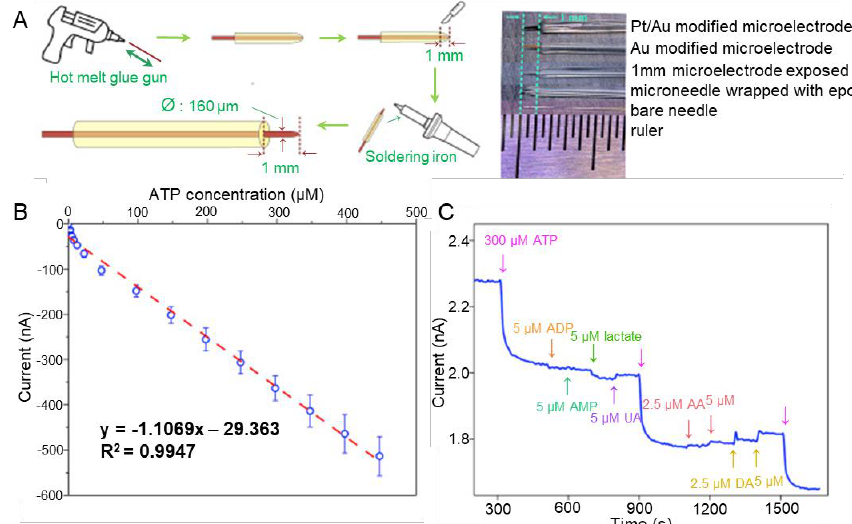
Figure 3. Au/Pt-hybrid-based needle-type aptamer sensors for detection of ATP as neurotransmitter. ( A ) Schematic illustration of the fabrication process of the metal-hybrid-based aptamer sensor. ( B ) Linear plot indicating the linear range and LOD of ATP. ( C ) Selectivity of the fabricated aptamer sensor. With permission from [61]. Copyright 2020, Elsevier. ATP, adenosine triphosphate; ADP, adenosine diphosphate; AMP, adenosine monophosphate; UA, uric acid; AA, ascorbic acid; DA, dopamine.